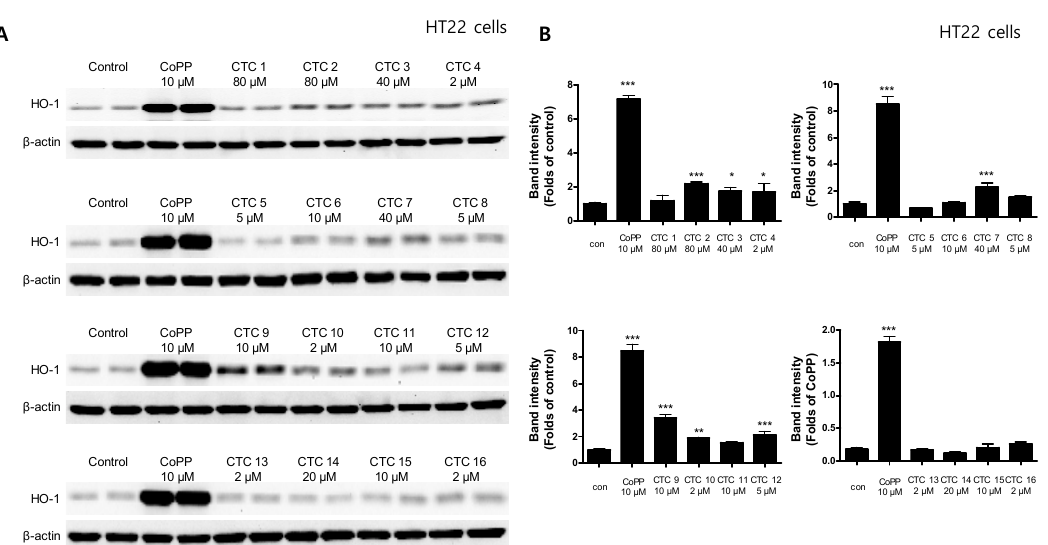
Figure 2. Effects of each of the sixteen C. tricuspidata compounds on the protein expression levels of HO-1 in HT22 cells. ( A ) Cells were treated for 12 h with the indicated concentration of each compound and assayed using Western blotting. Immunoblotting was performed using ImageJ software. ( B ) Band intensities were normalized to β -actin. CoPP (10 μ M) was used as a positive control. Data are presented as the mean ± standard deviation of four independent experiments. * p < 0.05, ** p < 0.01, *** p < 0.001 when compared to the untreated control.